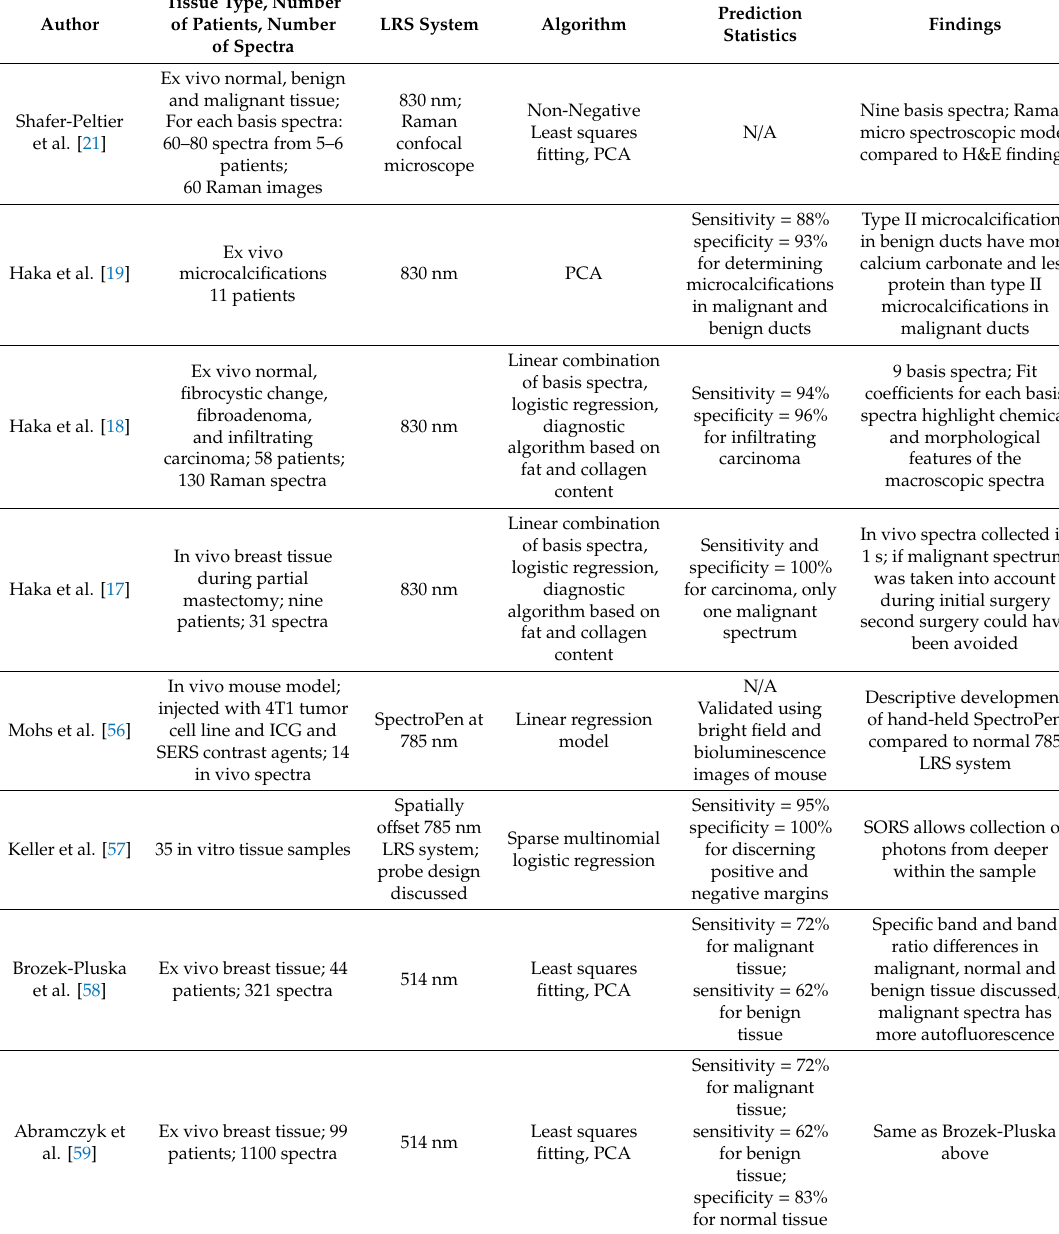
Table 2. Summary of major research findings in use of LRS for breast cancer